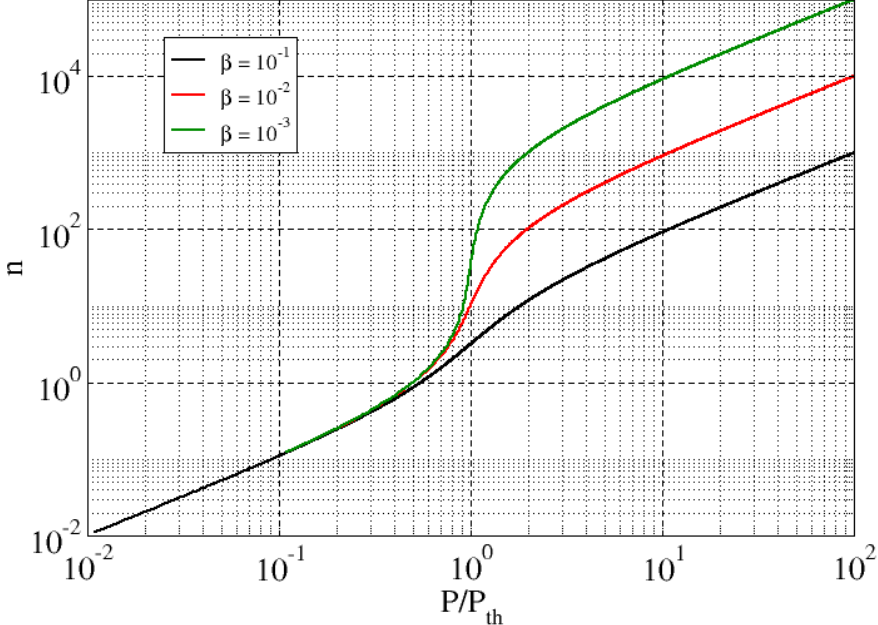
Figure 5. Laser characteristic response in double-logarithmic scale as a function of normalized pump, for different values of β (cf.